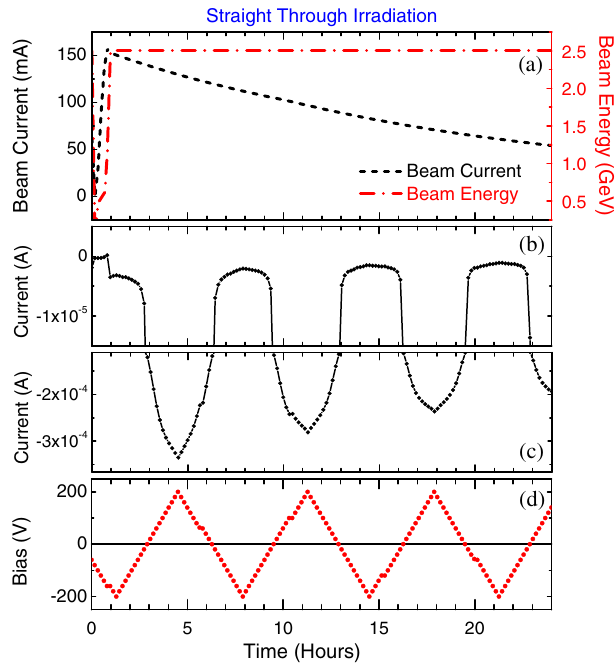
FIG. 10. Evolution as a function of time, during a 24 h KARA working cycle and irradiation in the straight-through configura- tion of (a) beam energy (red line) and beam current (black line), (b),(c) current measured at the photon cup ’ s electrode, at different applied bias voltages (positive and negative, respectively), and (d) bias voltage applied to the photon cup ’ s